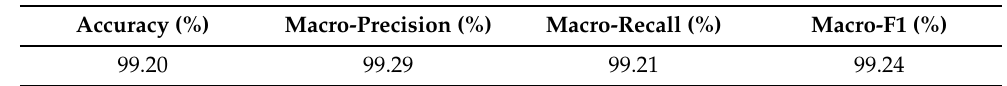
Table 2. Classification